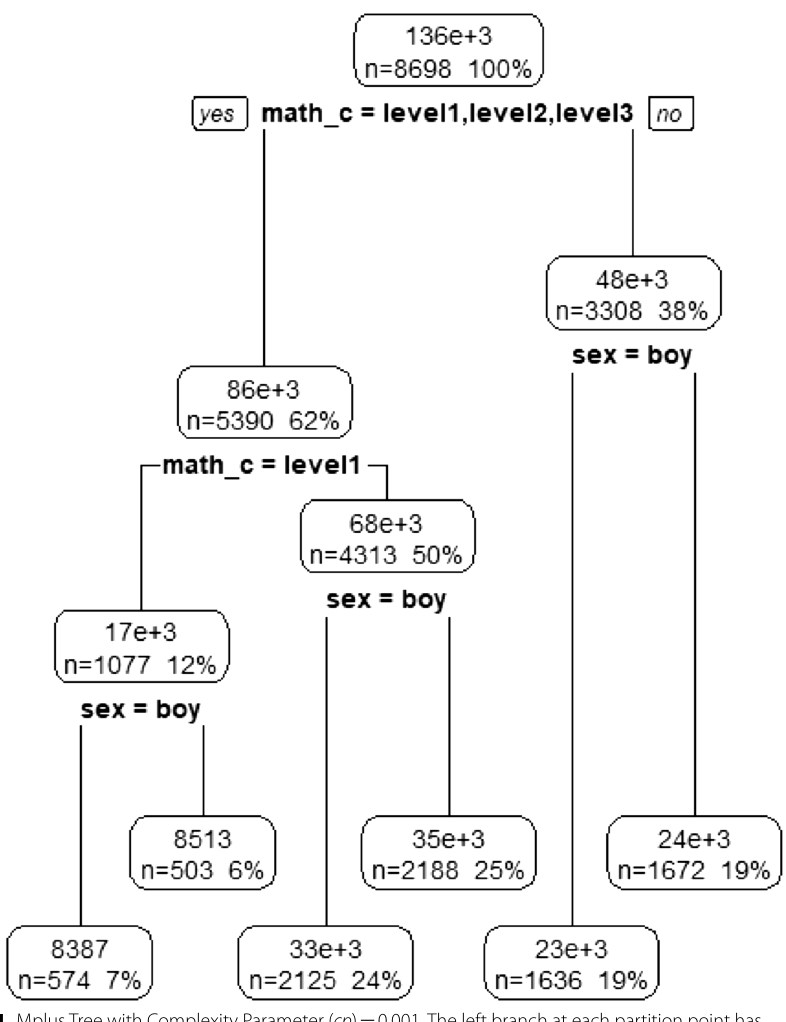
Fig. 1 Mplus Tree with Complexity Parameter ( cp ) 0.001. The left branch at each partition point has = observations that meet the condition (i.e. the result of testing the condition is “yes”). The right branch at each partition point has observations that do not meet the condition (i.e. the result of testing the condition is “no”)